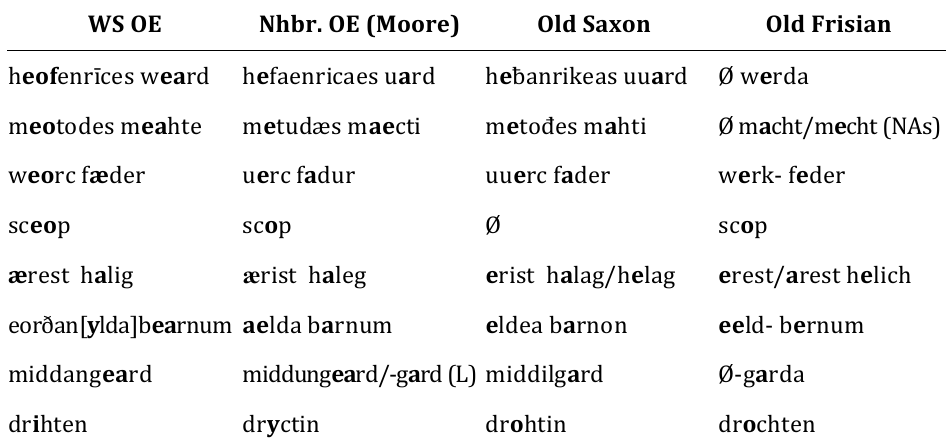
Table 3 : Words from Cædmon’s Hymn in the early-Northumbrian Moore-version, compared to the word forms from the West Saxon version and their Old Saxon and Old Frisian cognates. Ø refers to unattested forms; the Old Saxon and Old Frisian forms come from Tiefenbach (2010) and Old Frisian corpora,